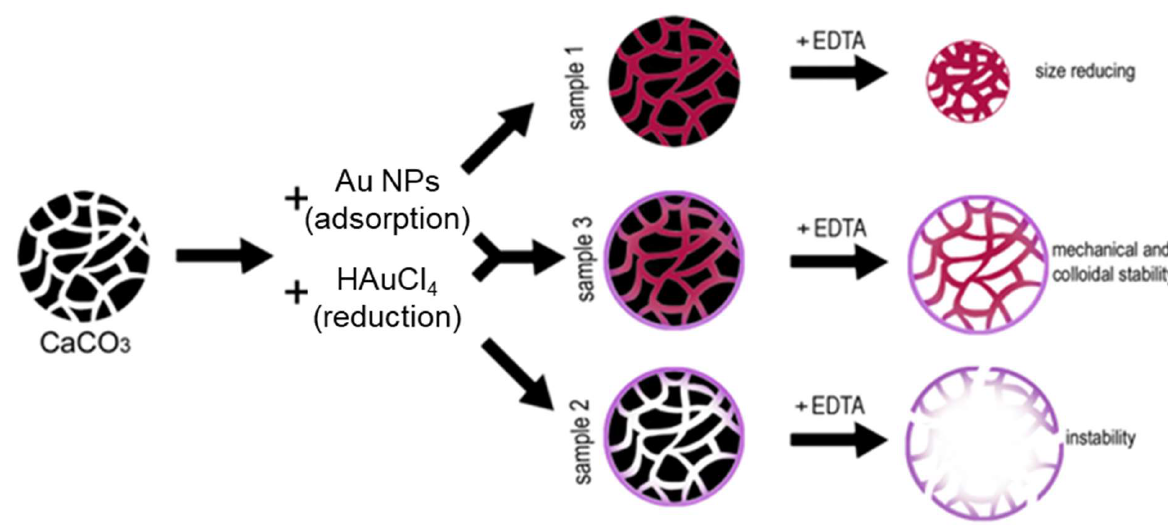
Figure 1. Three methods of fabrication of porous Au microparticles: sample 1, ex situ adsorption of Au NPs; sample 2, in situ reduction of HAuCl 4 ; sample 3, adsorption of Au NPs followed by the reduction of HAuCl 4 (combination of methods 1 and